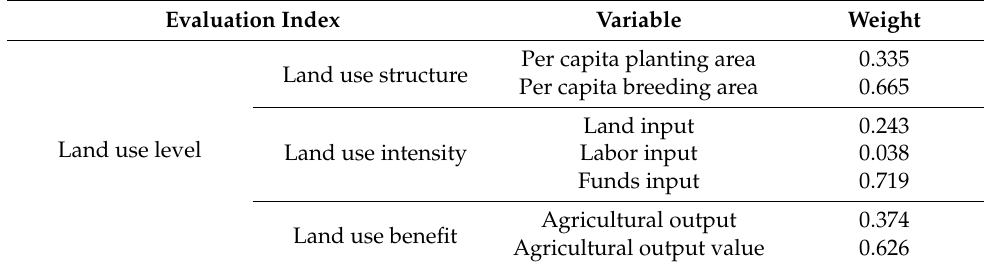
Table 3. Evaluation index system of farmers’ land use level.